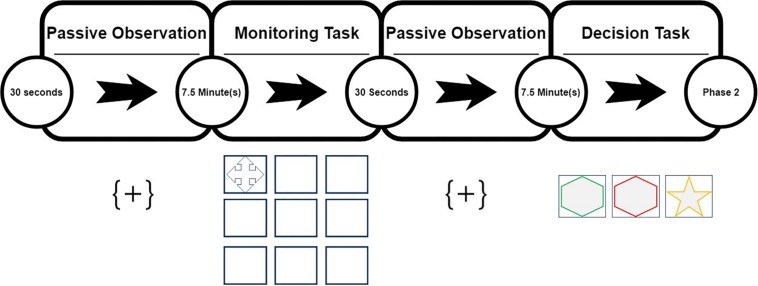
Phase 1 calibration task.